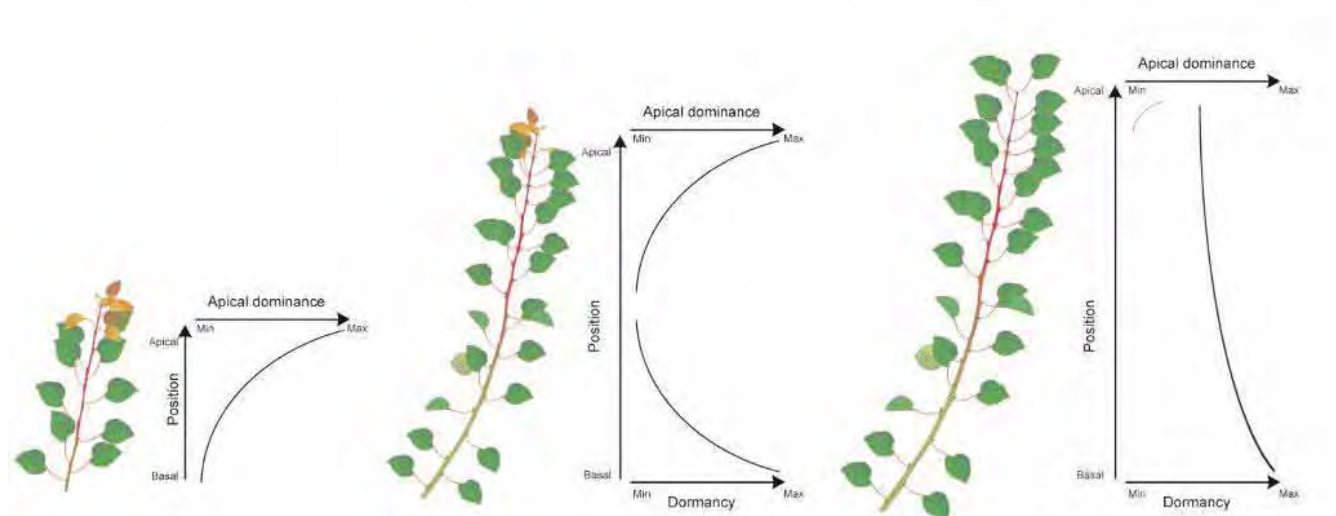
Fig. 2 - Left: apical dominance intensity along the growing shoot in early spring. Centre: apical dominance and bud dormancy intensity along the growing shoot in late spring. Right: apical dominance and bud dormancy intensity along the shoot in late summer.